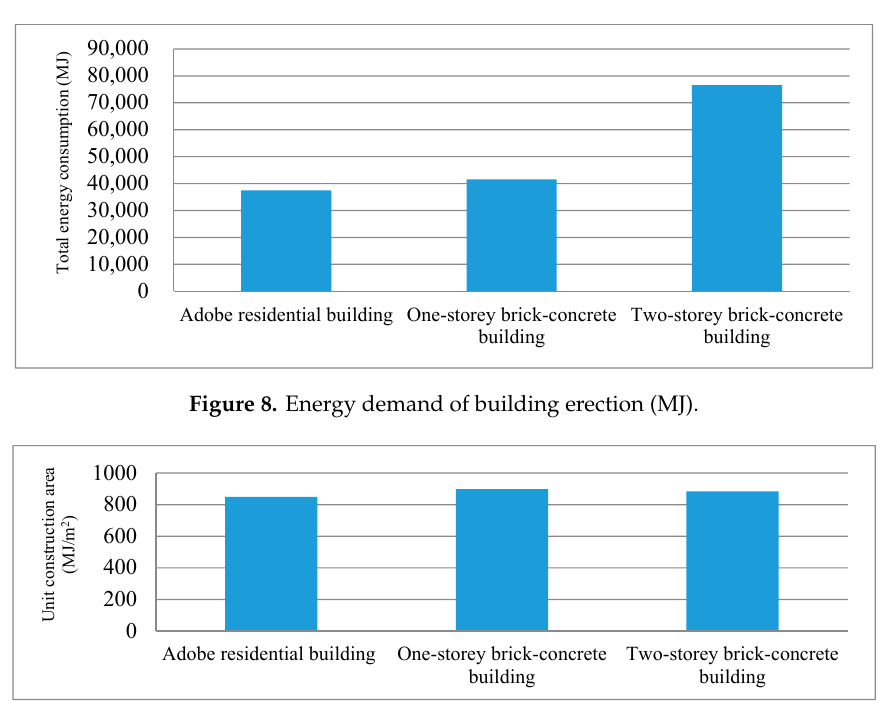
Figure 9. Energy demand of building erection in unit construction area (MJ).